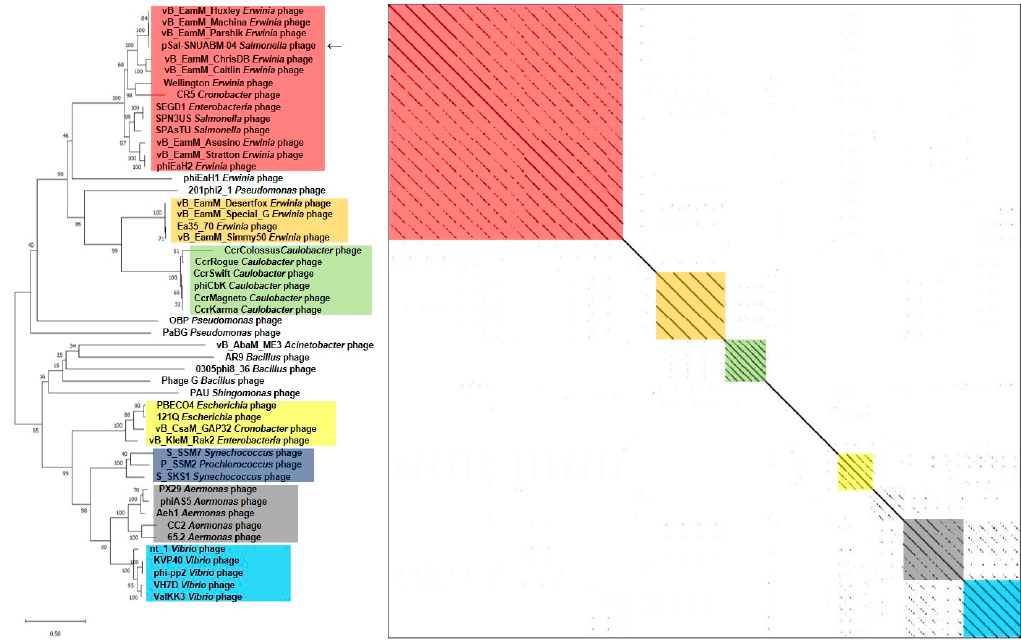
Figure 5. Comparative analysis of pSal-SNUABM-04 using major capsid protein sequences. The phylogenetic tree was constructed using MEGA-X by maximum likelihood with 1000 bootstrap replications. The dot plot was generated with Gepard software at a word size of 10.